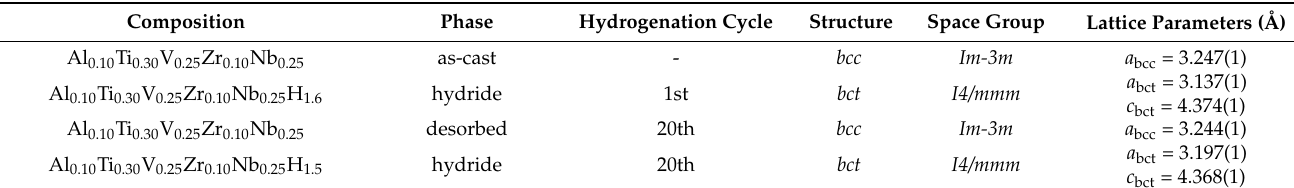
Table 1. Lattice parameters of the Al 0.10 Ti 0.30 V 0.25 Zr 0.10 Nb 0.25 alloy and corresponding hydride phase before and after 20 hydrogenation cycles. The lattice parameters of all phases were determined by the Rietveld refinement of diffraction patterns from laboratory XRD and SR-XRD for the hydride after the first hydrogenation.